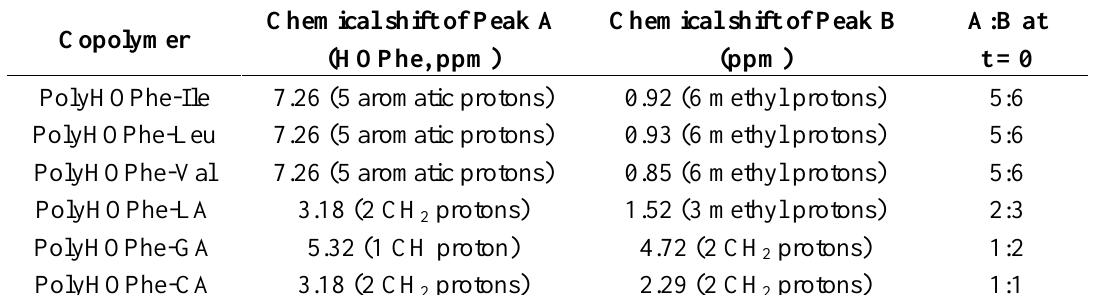
Table 6. NMR peaks corresponding to unit A (-OPhe-) and B in the copolymers PolyHOPhe-B and their initial ratios.